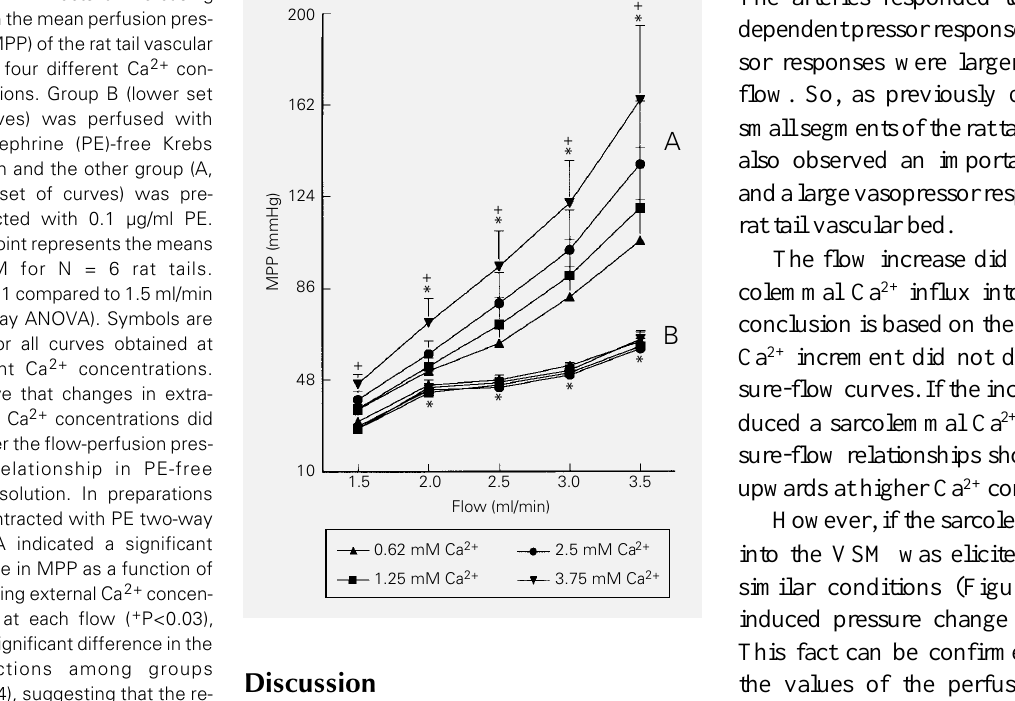
Figure 2 - Effects of increasing flow on the mean perfusion pres- sure (MPP) of the rat tail vascular bed at four different Ca 2+ con- centrations. Group B (lower set of curves) was perfused with phenylephrine (PE)-free Krebs solution and the other group (A, upper set of curves) was pre- contracted with 0.1 µg/ml PE. Each point represents the means ± SEM for N = 6 rat